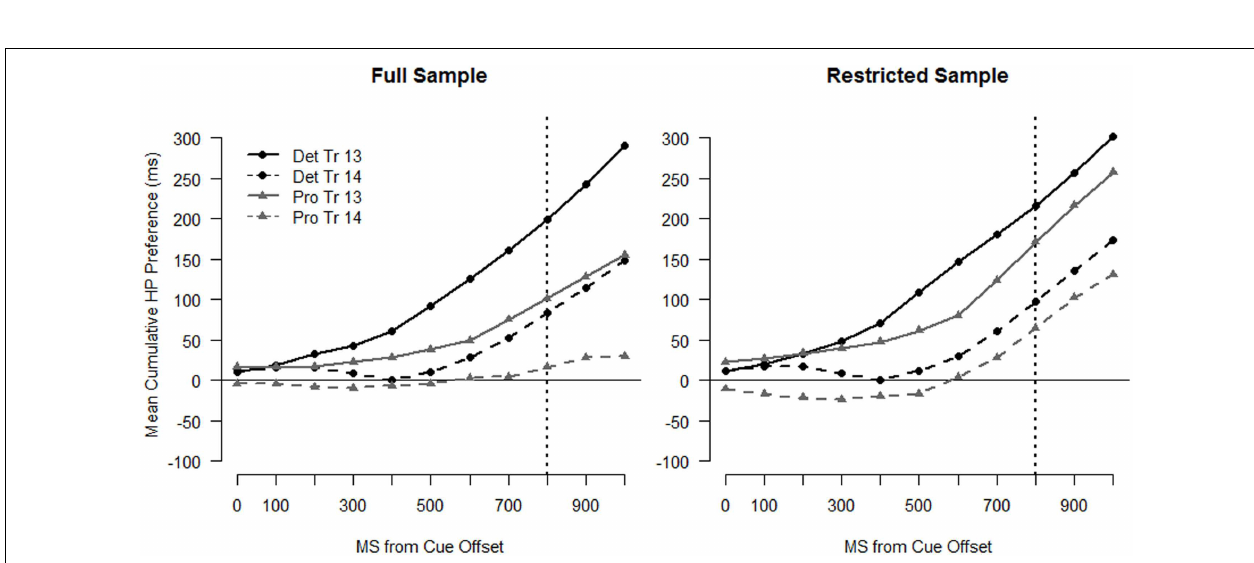
FIGURE 6 | Cumulative time spent looking to the high probability (HP) and low-probability (LP) location for infants in the Deterministic condition (left panel) and infants in the Probabilistic condition (right panel) forTrial 13 andTrial 14. The dotted vertical line indicates target onset.